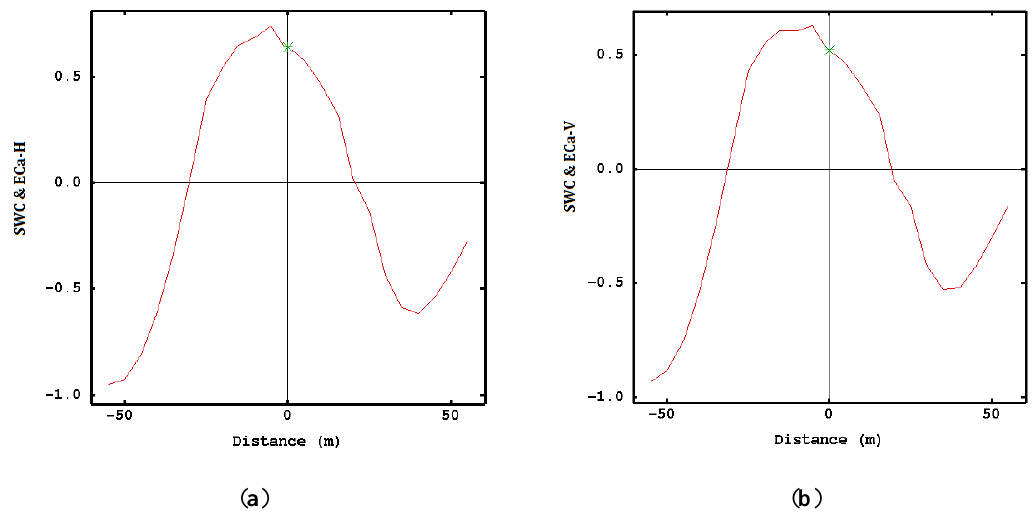
Figure 5. Cross correlogram between SWC and EC a in ( a ) horizontal polarization and EC a in ( b ) vertical polarization. Correlation coefficients at lag 0 are significant at a 0.05 probability level.